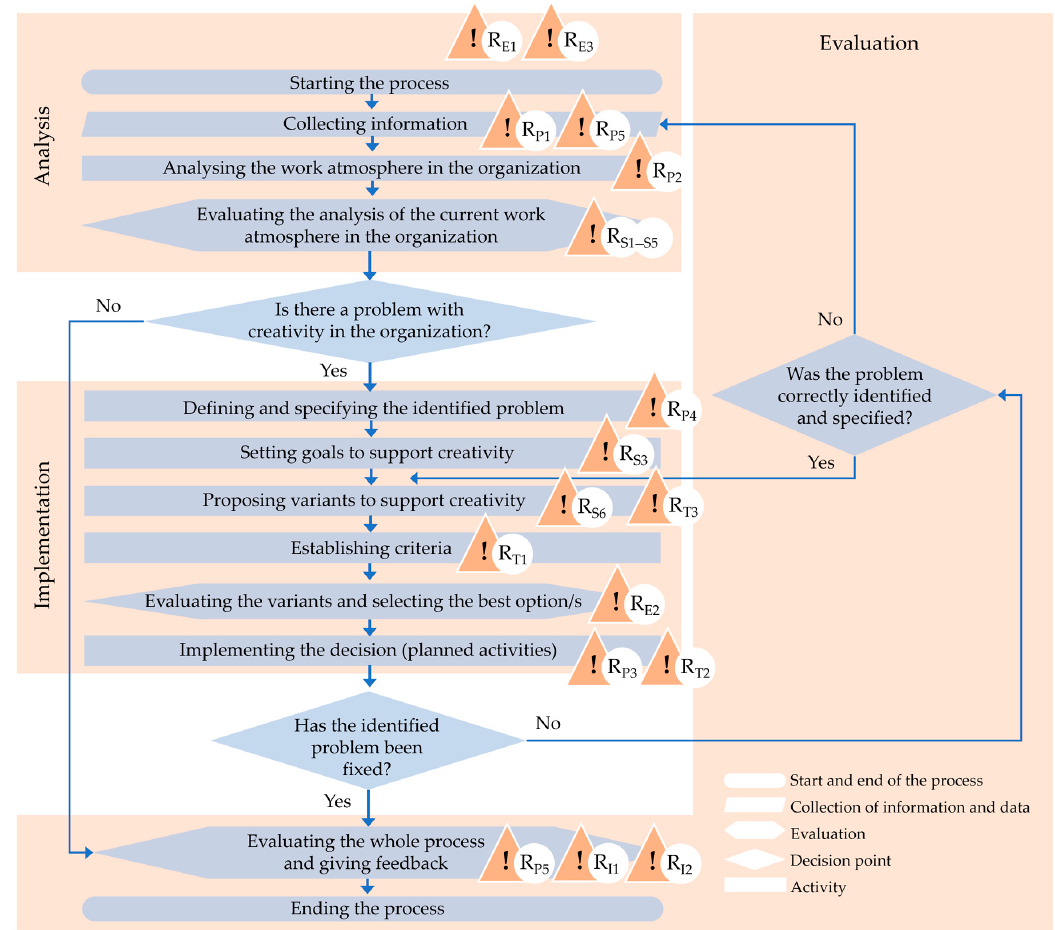
Figure 2. Building the atmosphere of trust and belonging from the perspective of employees and students (own elaboration). students (own elaboration).